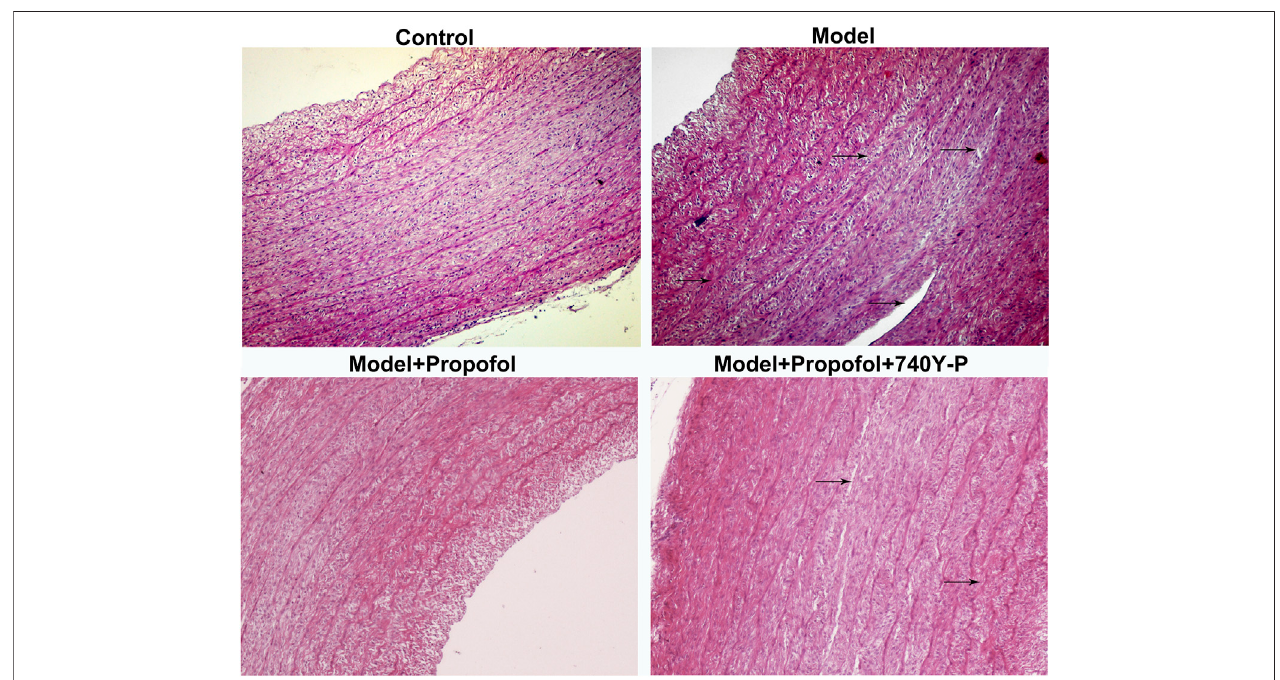
FIGURE 7 | H & E staining for the endothelial damage in AS mouse models treated with Propofol and / or 740Y-P. The arrow points to the lesion. Bar (cid:2) 20 ° μ m.